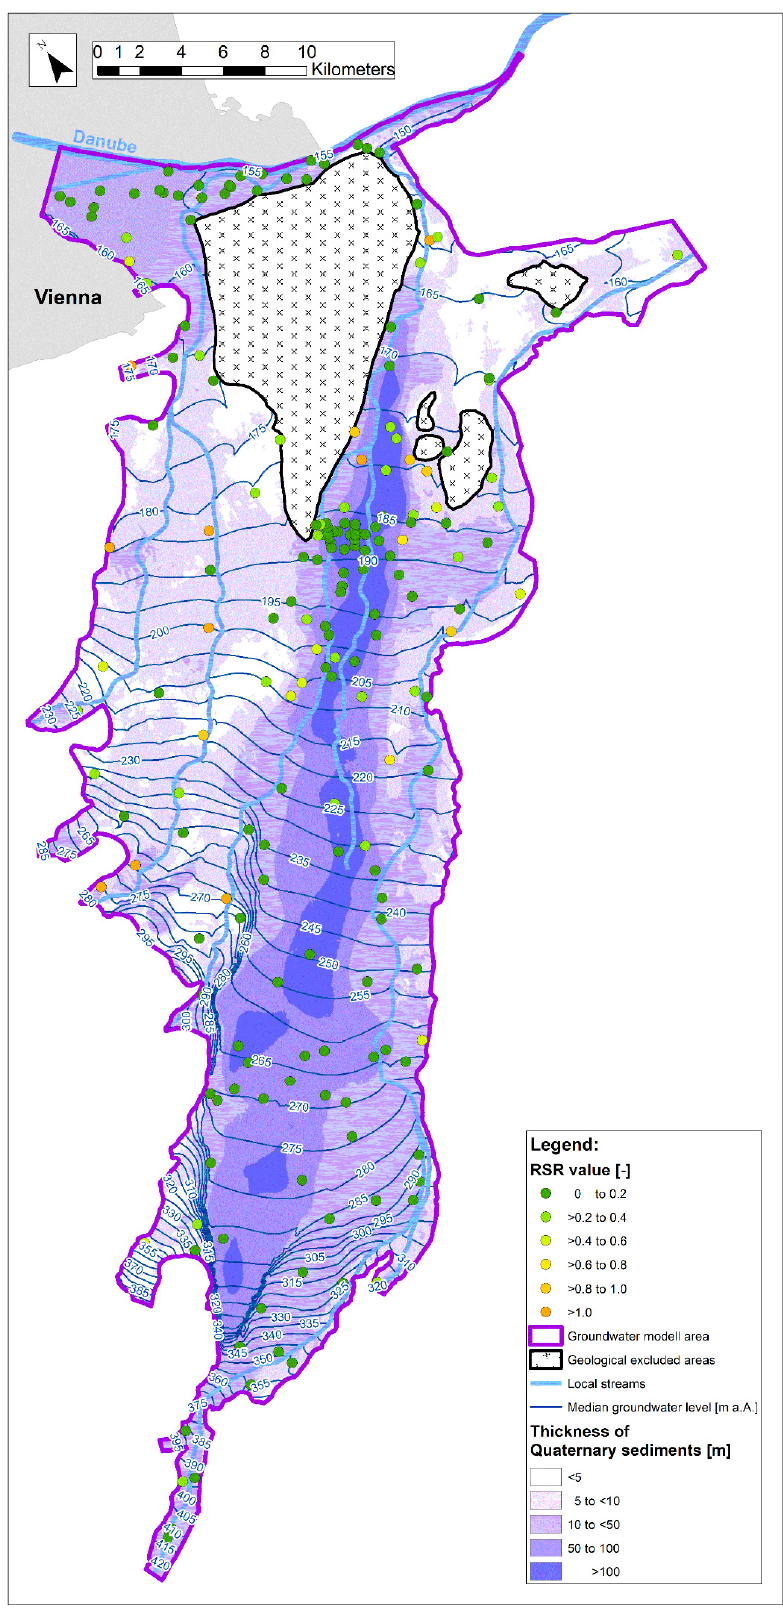
Figure 2. Distribution of saturated thickness for median groundwater level conditions in the SWB aquifer, indication of calibration quality (RSR-value) of the groundwater model at the observation wells.